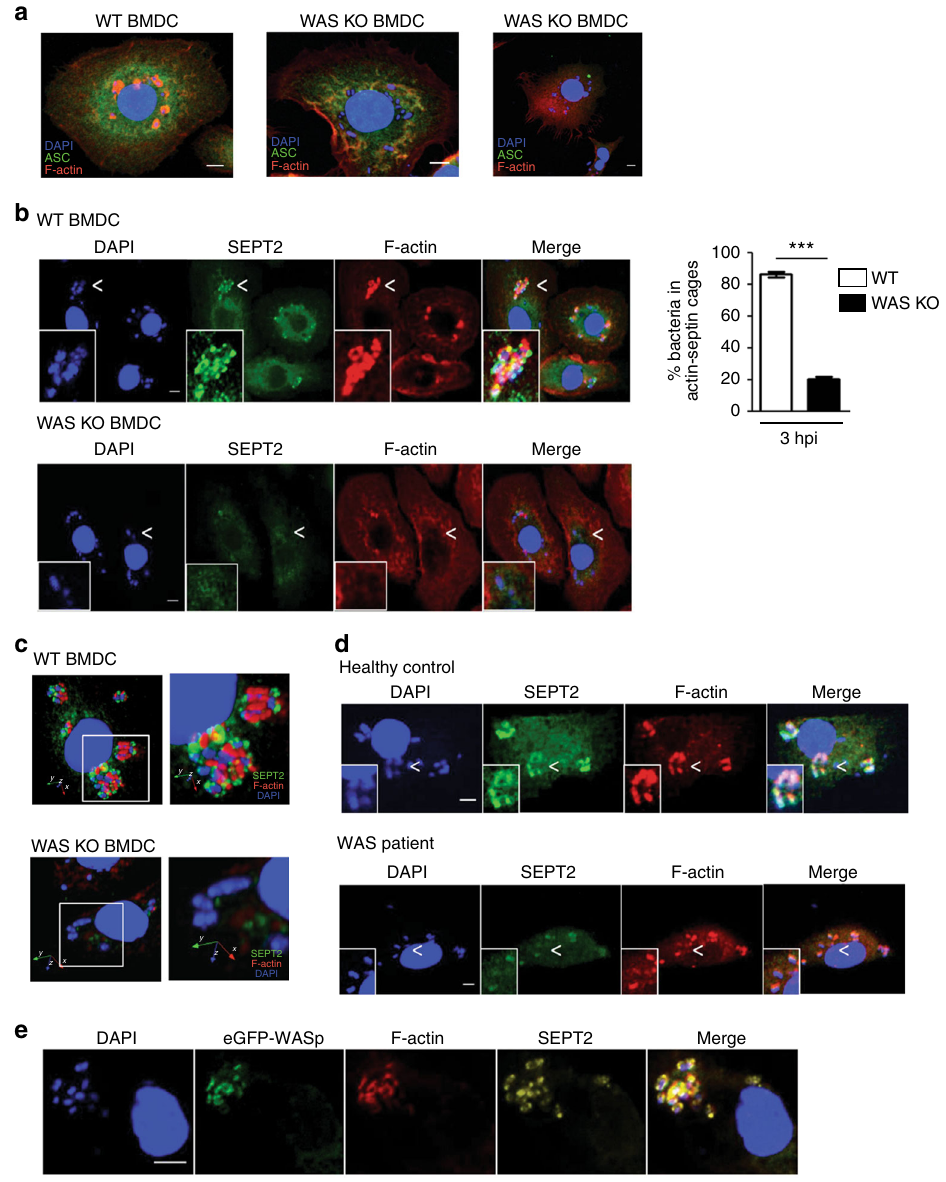
Fig. 4 Reduced actin recruitment and septin cage formation in WAS. a WT (left) or WAS KO BMDCs (middle and right) were co-cultured with WT EPEC (MOI of 5). At 3 h after co-culture, cells were fi xed and stained for bacteria (DAPI (4 ′ ,6-diamidino-2-phenylindole)), ASC (green) and F-actin (red). Images were taken by confocal microscopy (×63 magni fi cation). Scale bar = 5 µ m. b WT (left upper panel) or WAS KO (left lower panel) BMDCs were co-cultured with WT EPEC at an MOI of 5. At 3 h after co-culture, cells were fi xed and stained for bacteria (DAPI), SEPT2 (green) and F-actin (red). Images were taken at ×63 magni fi cation. Scale bar = 5 µ m. Percentage of bacteria enclosed by F-actin and SEPT2 were enumerated (right). Quanti fi cation was performed on at least 1,000 bacteria from two independent experiments. Data are presented as mean ± SEM. Two-sided Student ’ s t -test. *** p < 0.001. c Three-dimensional reconstruction of septin cages entrapping EPEC in WT (upper panel) and WAS KO BMDCs (lower panel) is shown (×63 magni fi cation). Scale bar = 5 µ m. See also Supplementary Movies 1 and 2. d Monocyte-derived macrophages from a healthy control (upper panel) and a WAS patient (lower panel) were co- cultured with WT EPEC (MOI of 5). At 3 h after co-culture fi xed cells were stained for bacteria (DAPI), SEPT2 (green) and F-actin (red). Images were taken at ×63 magni fi cation. Scale bar = 5 µ m. e WAS KO BMDCs were transduced with lentiviral vector expressing eGFP fused to human WASp. Transduced cells were co-cultured with WT EPEC (MOI of 5). At 3 h after co-culture, infected BMDCs were fi xed and stained for SEPT2 (red) and F-actin (yellow). WASp-GFP (green), SEPT2 and F-actin formed ring-like structures around bacteria. Images were taken at ×63 magni fi cation. Scale bar = 5 µ